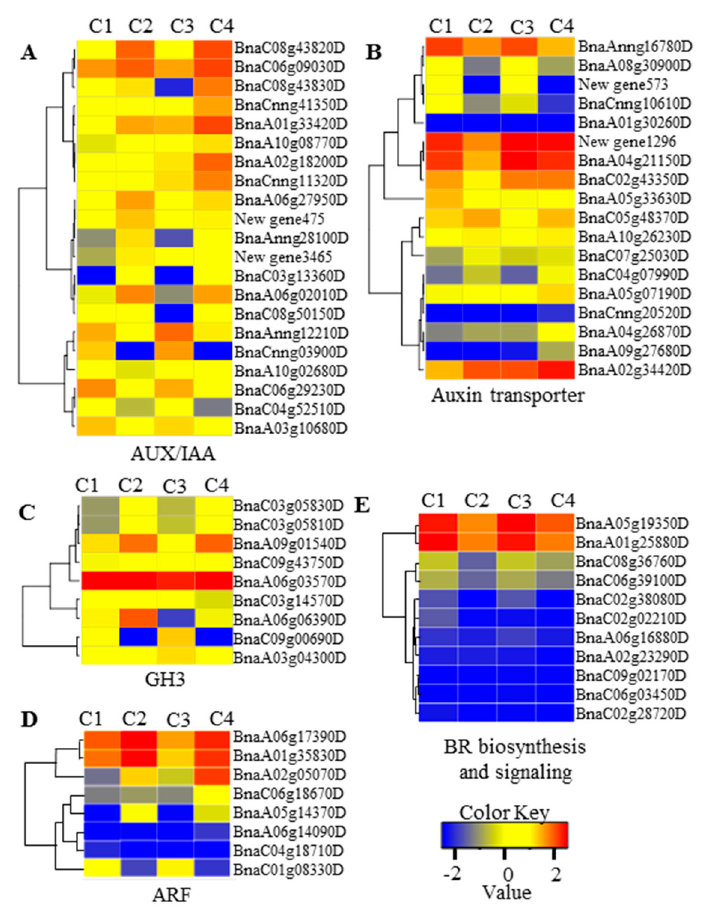
Figure 5. Heat maps of DEGs related to the auxin and BR signaling pathways showing ( A – D ) the cluster of DEGs involved in auxin signaling transduction and ( E ) the cluster of DEGs involved in BR biosynthesis and transduction. Tissue samples from 6098B (C1, C3) and Purler (C2, C4) at the bolting and early flowering stages, respectively. Color key represents log2 transformed FPKM (fragments per kilobase of exon per million fragments mapped) values, from low (blue) to high (red) expression.